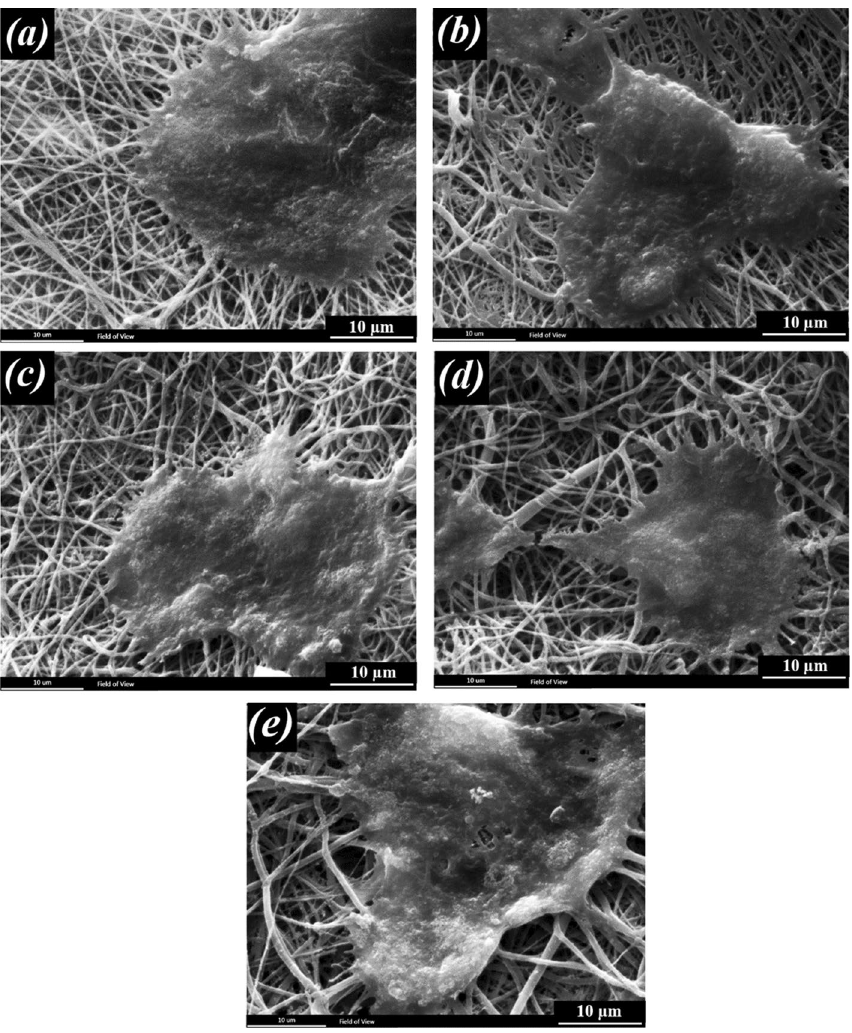
Figure 14. Morphology of the ARPE cells on the scaffolds after 1 day of culture, ( a ) PCL ( b ) PCL-10HAMP ( c ) PCL-20HAMP, ( d ) PCL-30HAMP, and ( e )